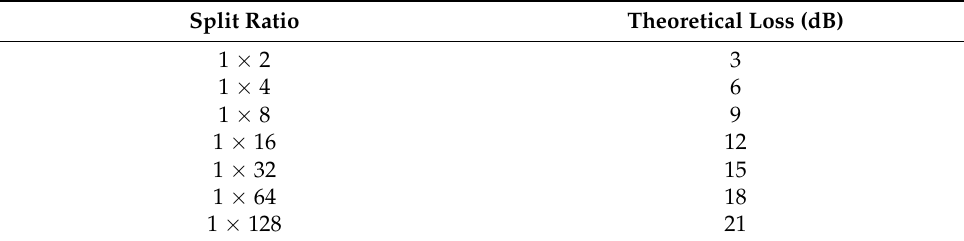
Figure 3. Generic FTTH protection concept. Table 2. Theoretical optical split ratio loss